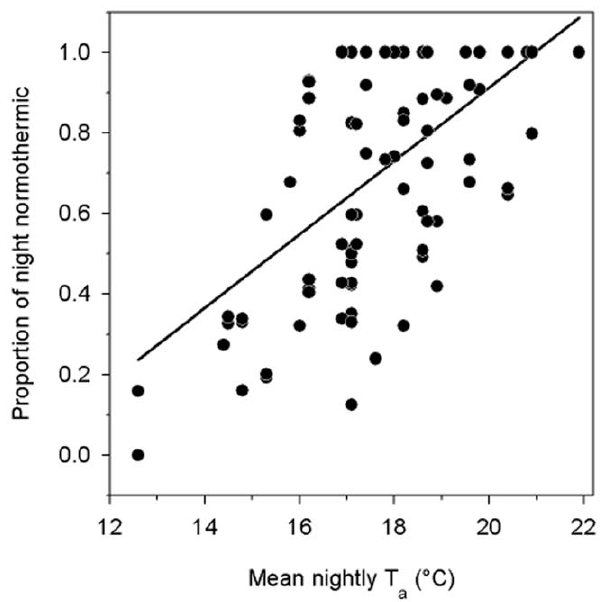
Figure 5. The proportion of a night that N. bifax spent normothermic as a function of mean nightly T a . This relationship is represented by the following equation: proportion night normother- mic = 2 0.9 + 0.09[T a u C]; R 2 =0.4, P , 0.001, F 1,95 =51.1.